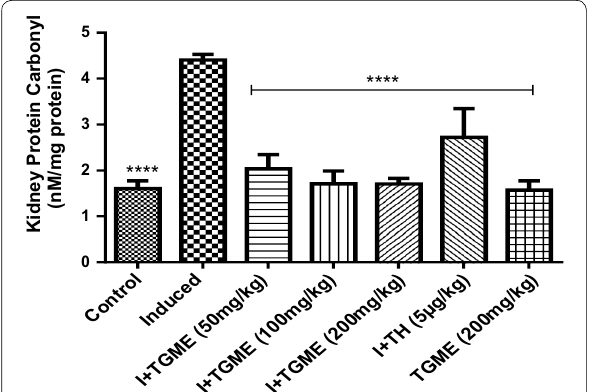
Fig. 7 Effect of aqueous methanolic leaf extract of Triclisia gilletii on plasma bicarbonate concentration in animals administered ethane-1,2-diol. Data are expressed as mean ( n 6); **** p < 0.0001; *denotes that data were compared with = ethane-1,2-diol; TGME Triclisia gilletii aqueous methanolic extract, TH